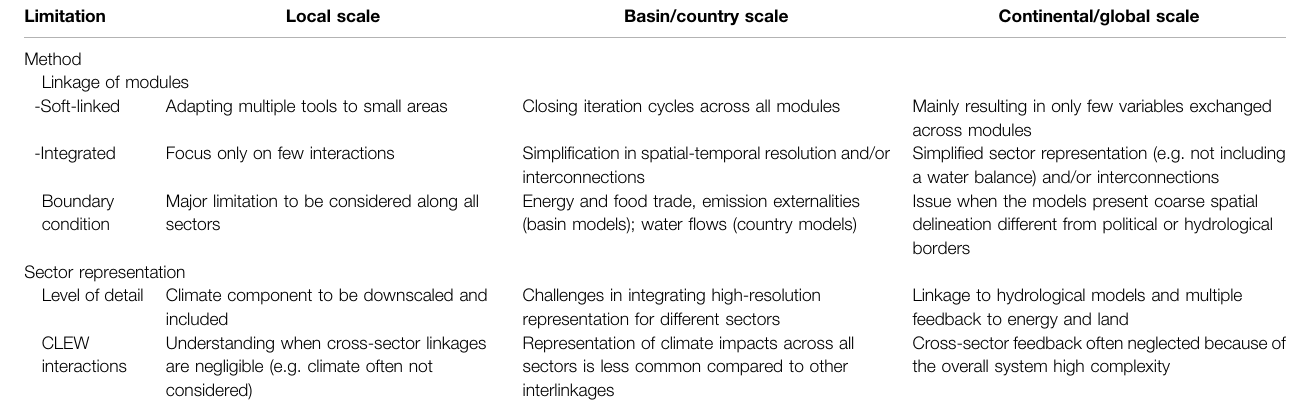
TABLE 3 | Summary of methodological